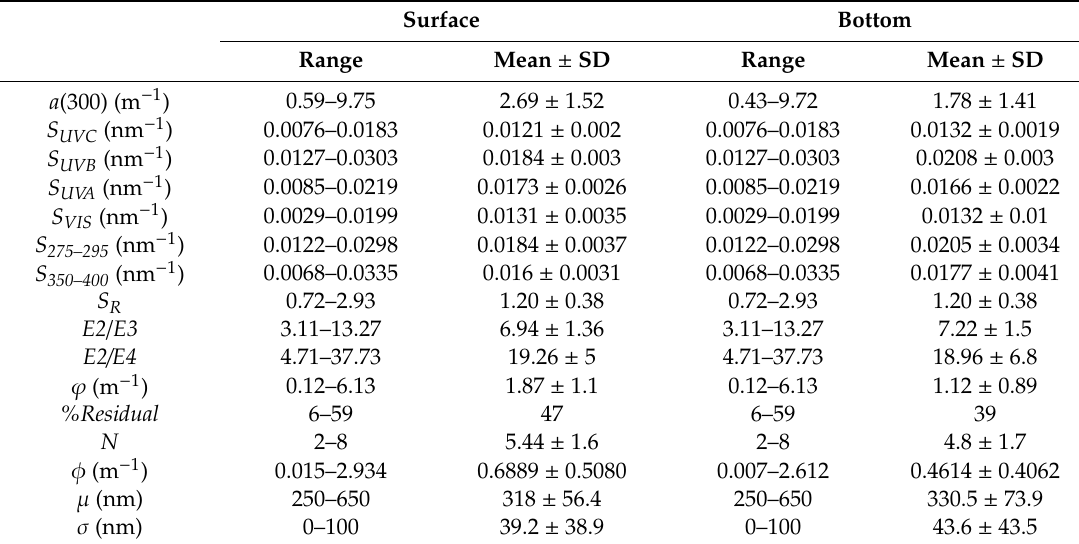
Table 1. The variation range, mean value, and standard deviation (SD) of the surface and bottom